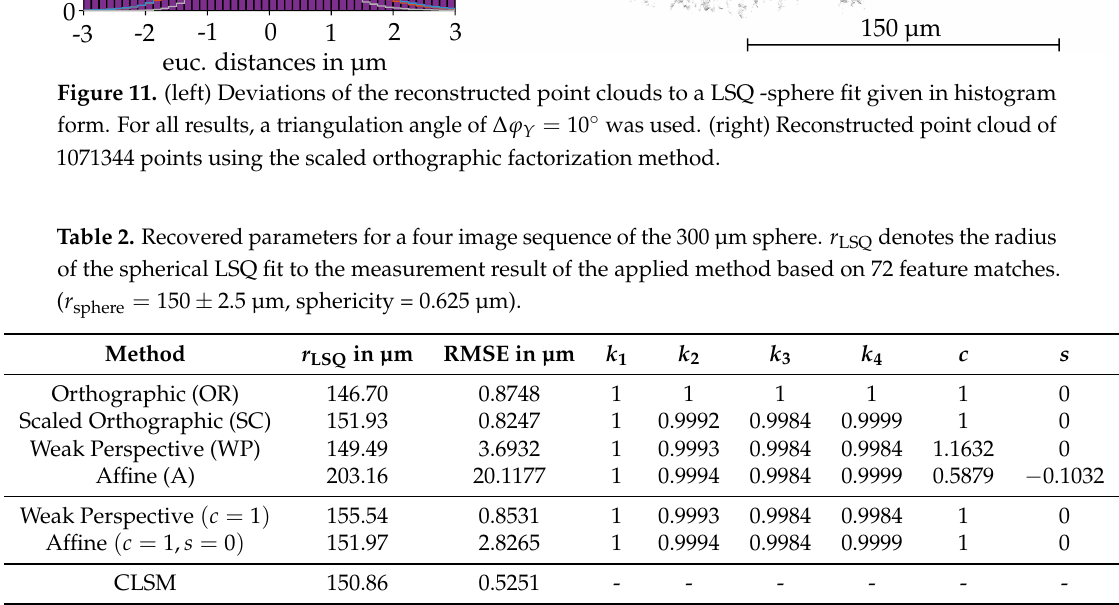
Table 3. Rotation angles for the different factorization methods and the four image sequence of the sphere with a radius of 150 ± 2.5 µm. The results are given selecting the first view as a reference view with ( ϕ X ,1 , ϕ Y ,1 , ϕ Z ,1 ) = ( 0 ◦ ,0 ◦ ,0 ◦ ) . The tilt motion was performed with ∆ ϕ Y ≈ 5 ◦ . Method Scaled Orthographic